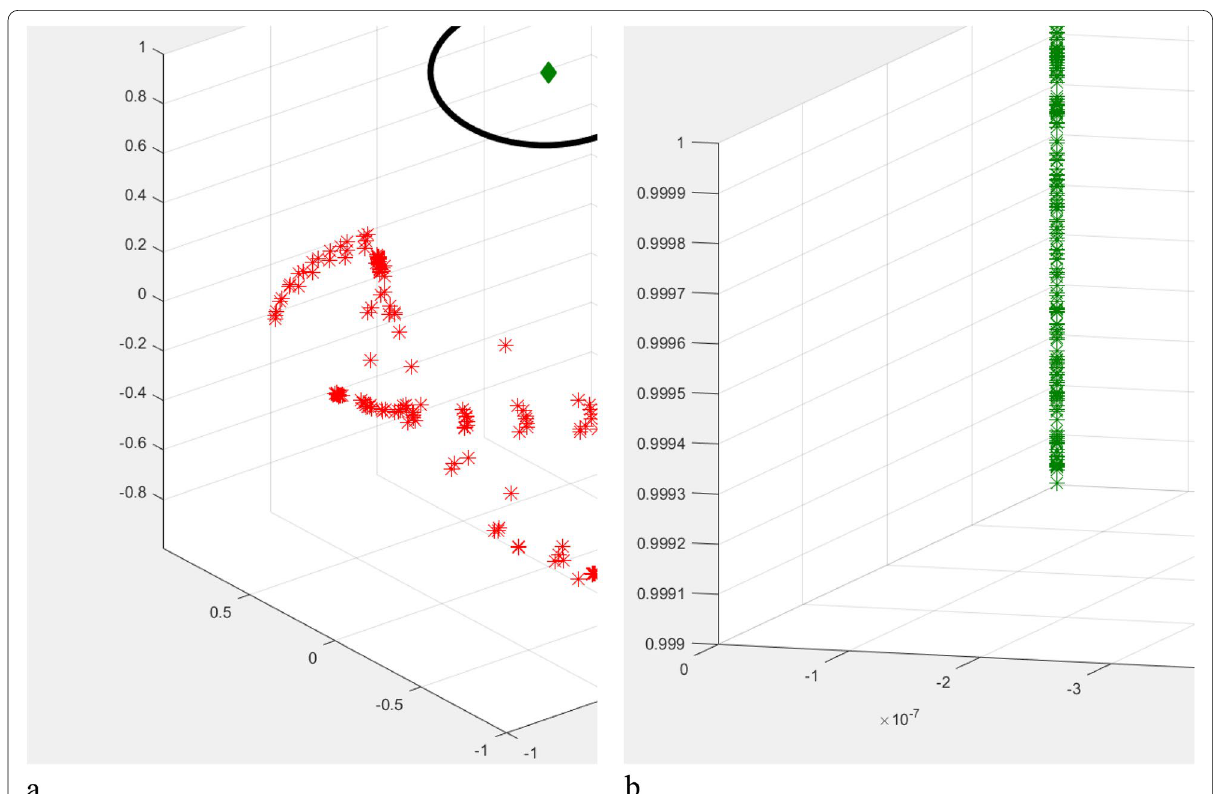
Fig. 5 Data points representing normal vectors. a Optimal dataset is shown in green; b Local enlarged portion of the optimal